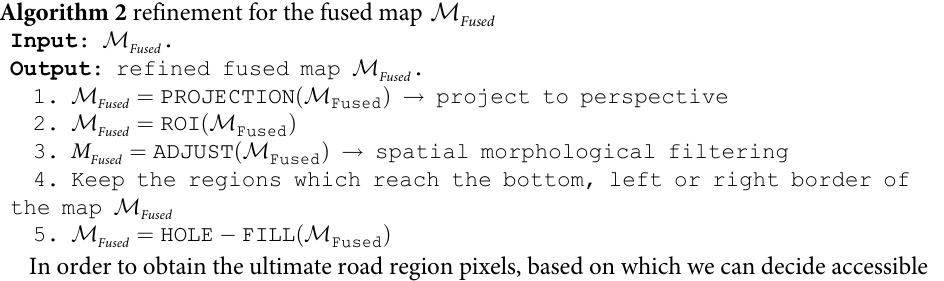
Algorithm 2 refinement for the fused map M